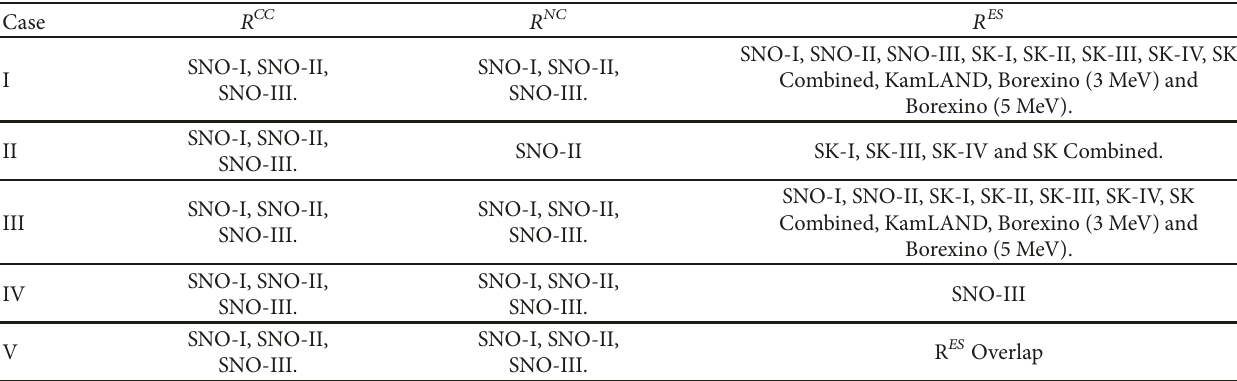
Figure 5: R 𝐸𝑆 Overlap region (shaded) from all experiments. Table 8: Different cases for 𝜒 2